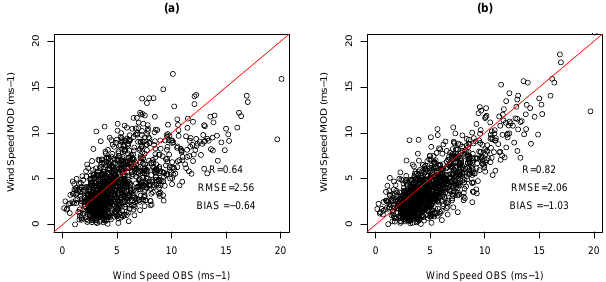
Fig. 6. Comparison of (a) TopoSCALE and (b) TopoSCALE + wind sub-model for ANETZ station at Natschen above Andermatt. The 2- pronged error signature is corrected by the sub-model. This station was chosen for its position on a large slope as opposed peak or ridge where slope angles are difficult to extract accurately from a